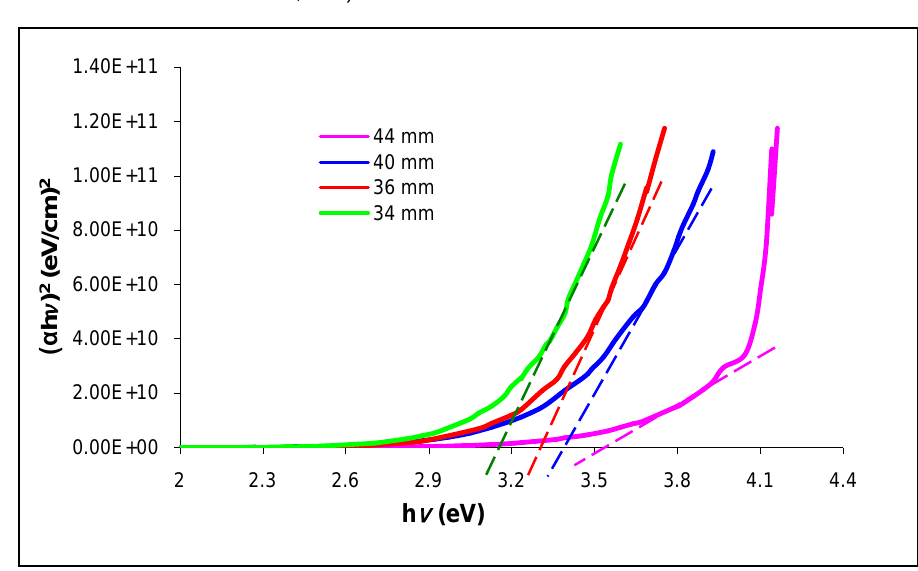
Fig. 4: Variation of (